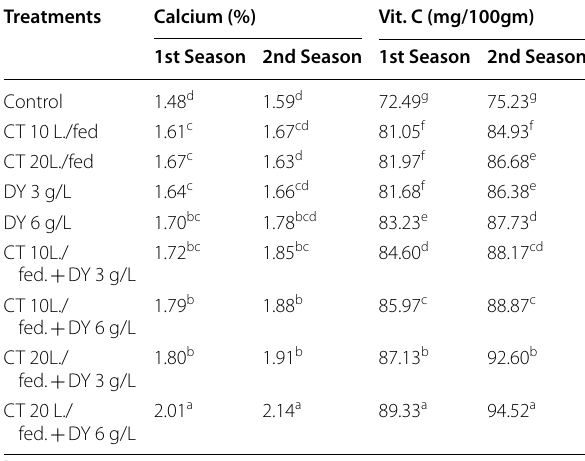
Table 10 Effect of compost tea, dry yeast and their mixture on fruit nutritional values of sweet pepper during 2018/2019